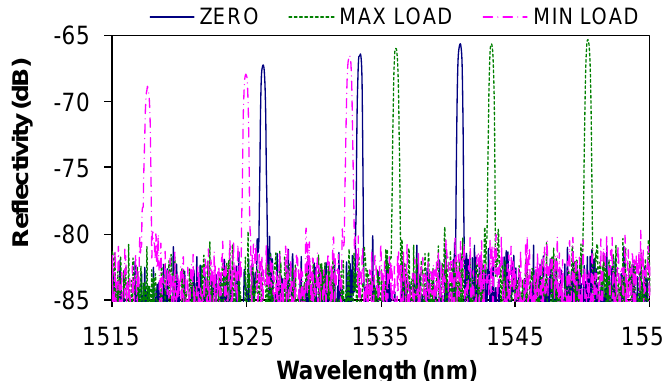
Figure 5. The spectra of the array at three different loads after 100 cycles at ±7,000 με strain